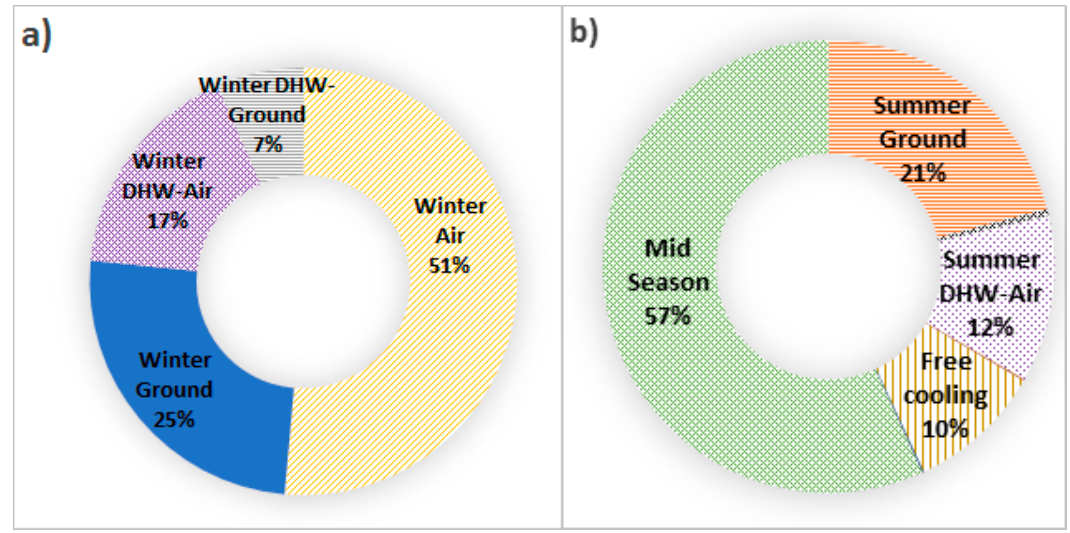
Figure 15. Working modes: ( a ) heating mode (winter); and ( b ) cooling mode (summer).